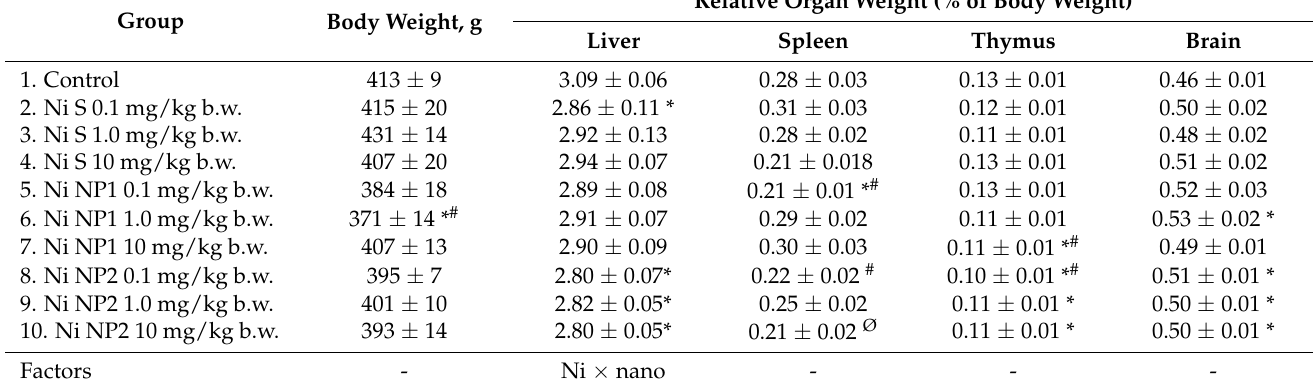
Figure 5. Average body weight of rats (g; M ± S.E.M.) during the experiment. *—the difference with the control group is significant; #—the difference with the group that received the Ni soluble salt (Ni S) in an equivalent dose is significant; p < 0.05. The number of animals is 12 in each group. At withdrawal from the experiment, as follows from the data in Table 2, rats of group 6 (Ni NP1, 1 mg/kg) had a significantly reduced body weight; they also had significantly increased brain weight; in some animals from this group, signs of hydrocephalus were noted at the section. At a minimum dose of Ni NP1, 0.1 mg/kg b.w. (group 5), there was a significantly reduced relative weight of the spleen, and at the maximum dose (10 mg/kg b.w., group 7), there was a reduced weight of the thymus. In rats of all groups that received Ni NP2 (from 8th to 10th), the weights of the liver and thymus were significantly reduced in comparison with the control, and the weights of the brain were significantly increased. crease, significant in the case of comparison with the corresponding groups receiving Ni soluble salt. This element form in the indicated doses did not affect the relative weight of internal organs, except for a decrease in the relative liver weight in group 2 (0.1 mg/kg b.w., according to Ni). Table 2. Mean (M ± S.E.M.) body weight and relative organ weight (% body weight) of rats at withdrawal from the experiment.